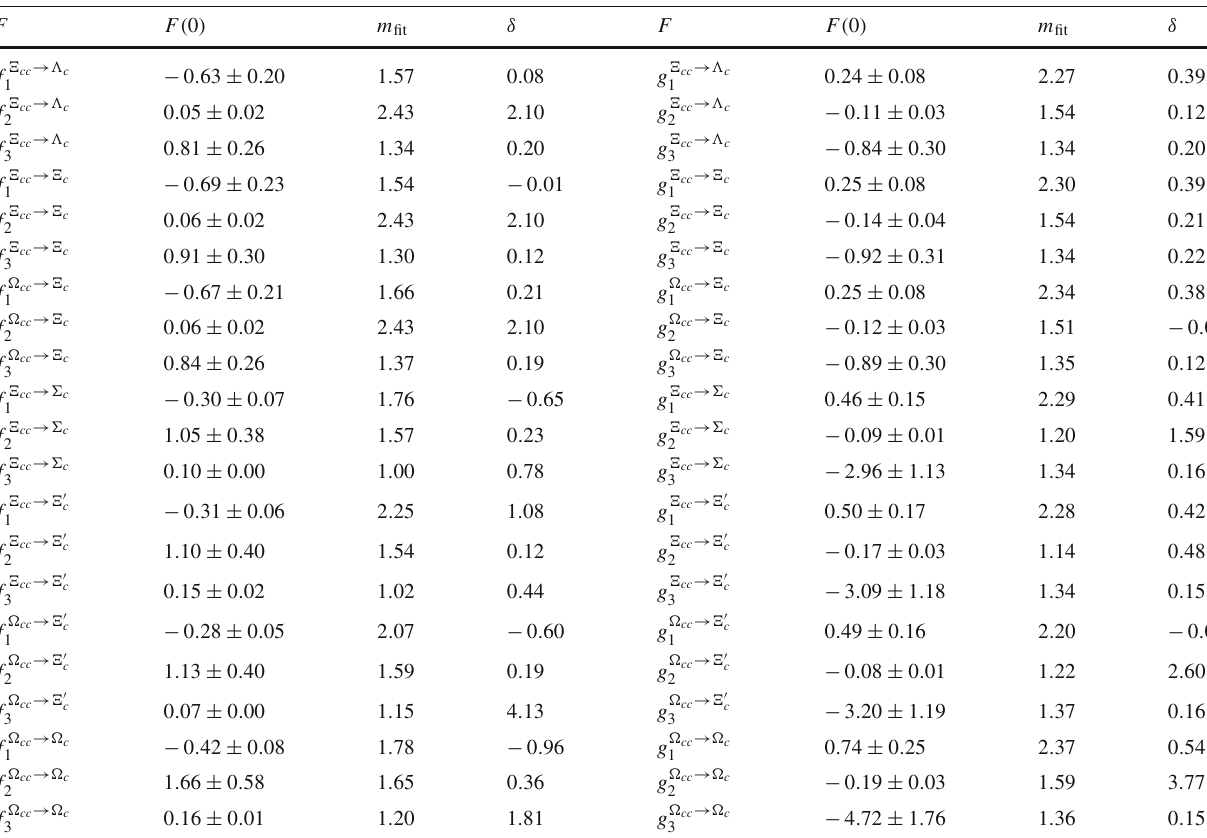
factor f 2 in the (cid:2) cc → (cid:2) c and (cid:5) cc → (cid:2) c transitions cannot be fitted well, the corresponding ( m fit ,δ) are taken from those in the (cid:2) cc → (cid:3) c transition. For F ( 0 ) , we have only considered the uncertainty from the heavy quark masses